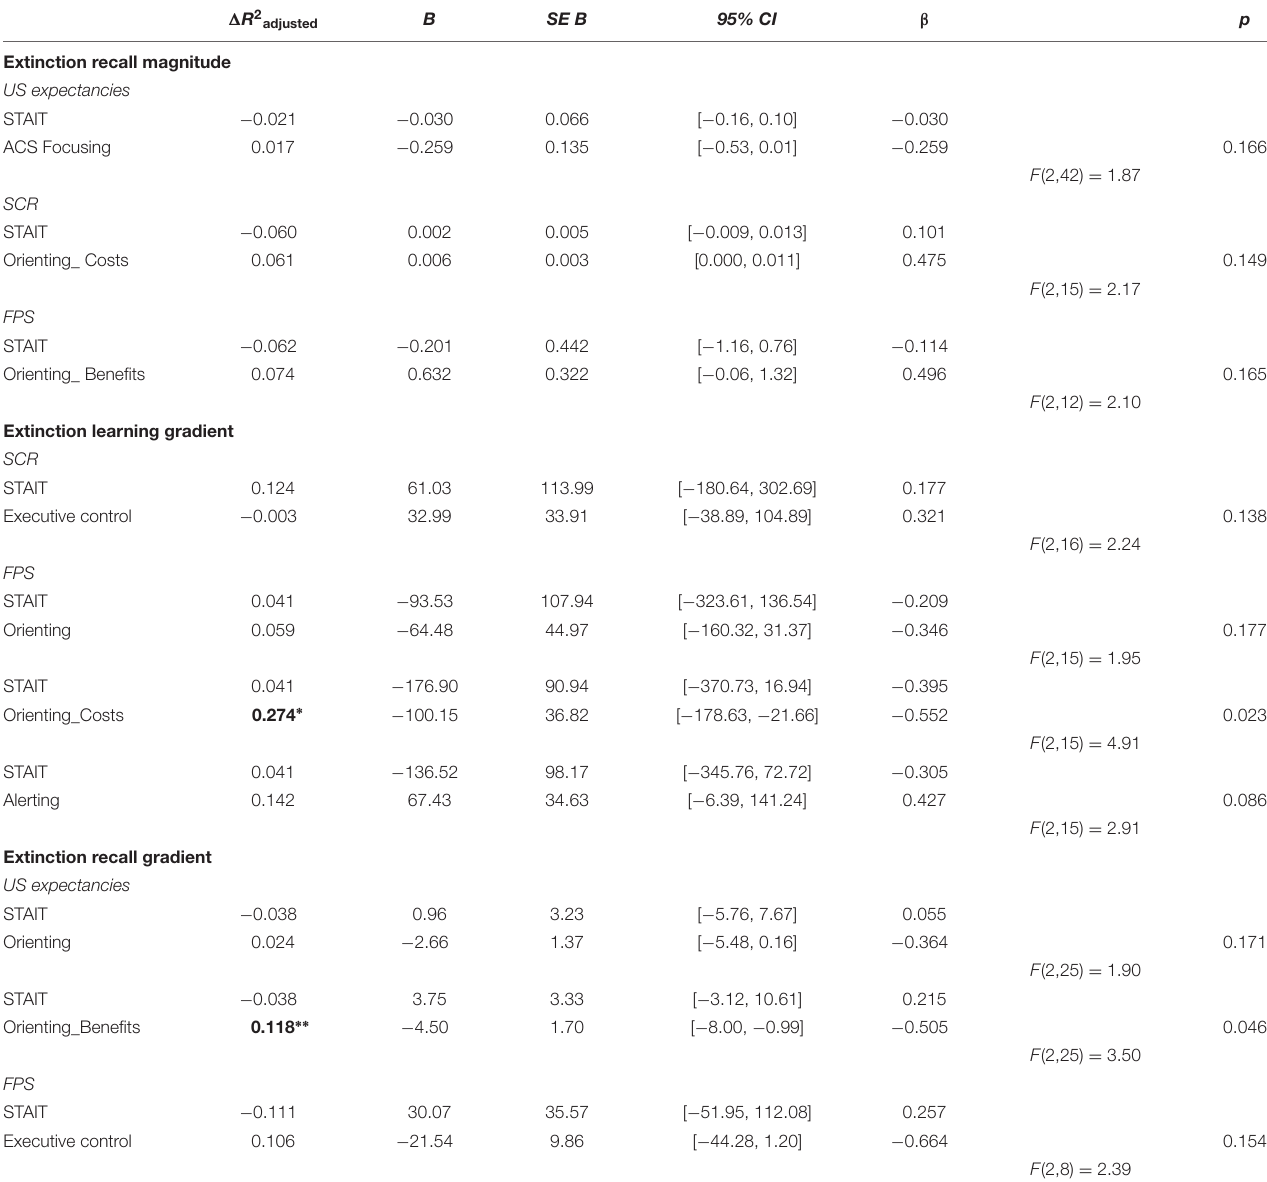
TABLE 3 | Summary of hierarchical multiple regression analyses predicting fear